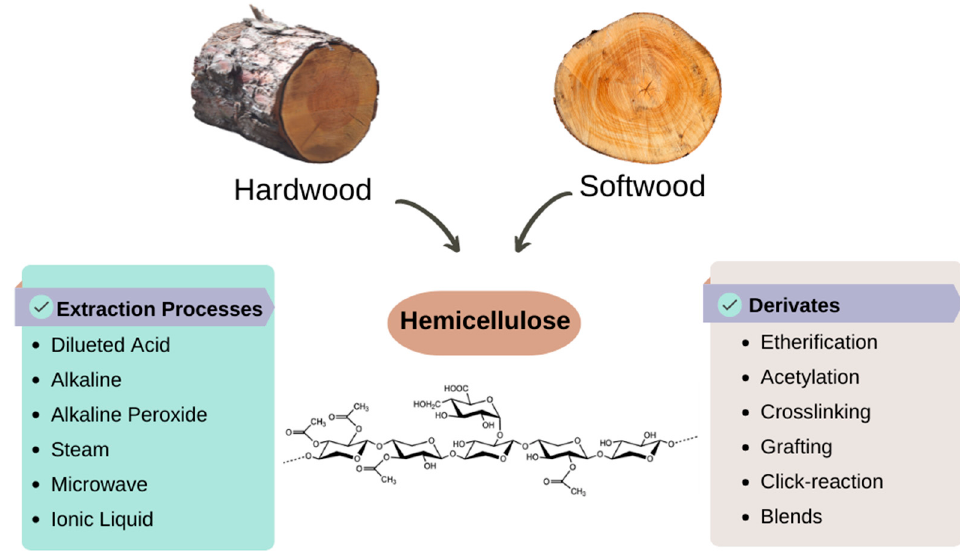
Figure 7. Hemicelluloses: Source from hardwoods, general structure, extraction routes, and deriva- tives mechanisms (Adapted with permission from Ref. [71]. Copyright 2017, Wiley).